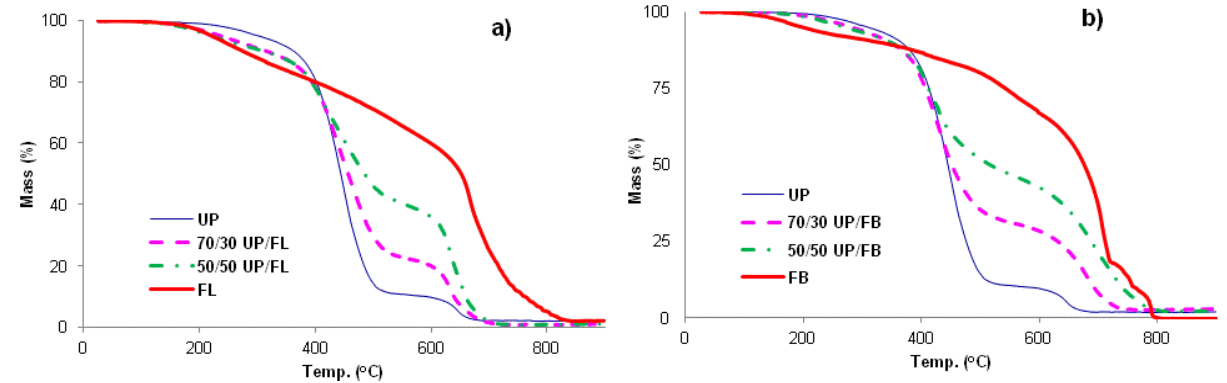
Figure 4. TGA traces for ( a ) cured UP, FL and UP/FL blends and ( b ) cured UP, FB and UP/FBblends. Table 2. Some parameters of degradation extracted from the TGA data plotted in Figure 4. Onset T of degradation Mass remaining Calculated mass remaining Resin (°C) at 600 °C (wt%) at 600 °C (wt%) * UP 165 10 - 70/30 UP/FL 90 20 25 50/50 UP/FL 110 FL - 70/30 UP/FB FB 85 67